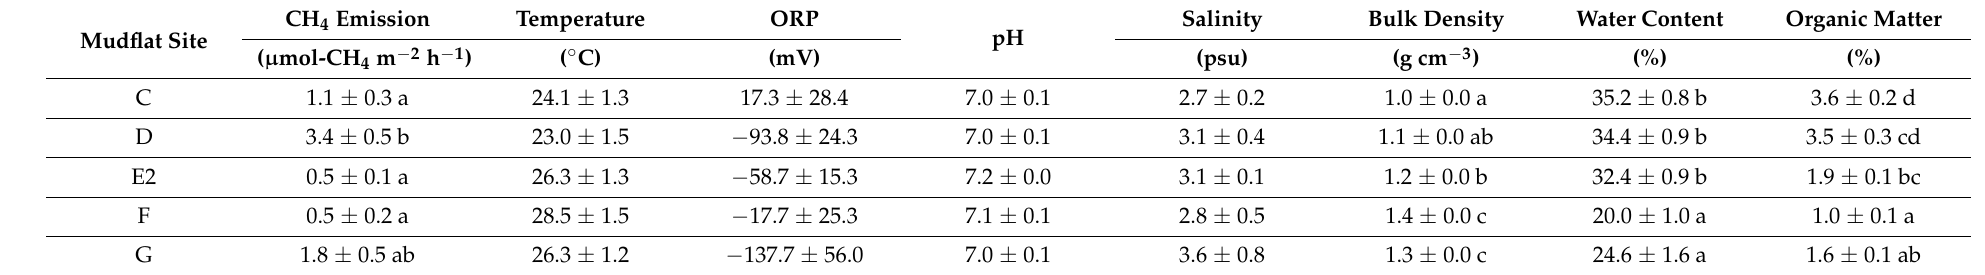
Table 3. CH 4 emissions and soil characteristics (mean ± standard error) of the mudflats at C—Xinfeng (XF); D—Zhunan (ZN); E—Fangyuan (FY); F—Budai (BD); G—Beimen (BM). Different letters represent significant site differences according to the Kruskal–Wallis test and Dunn’s test at the significance level. ORP—redox